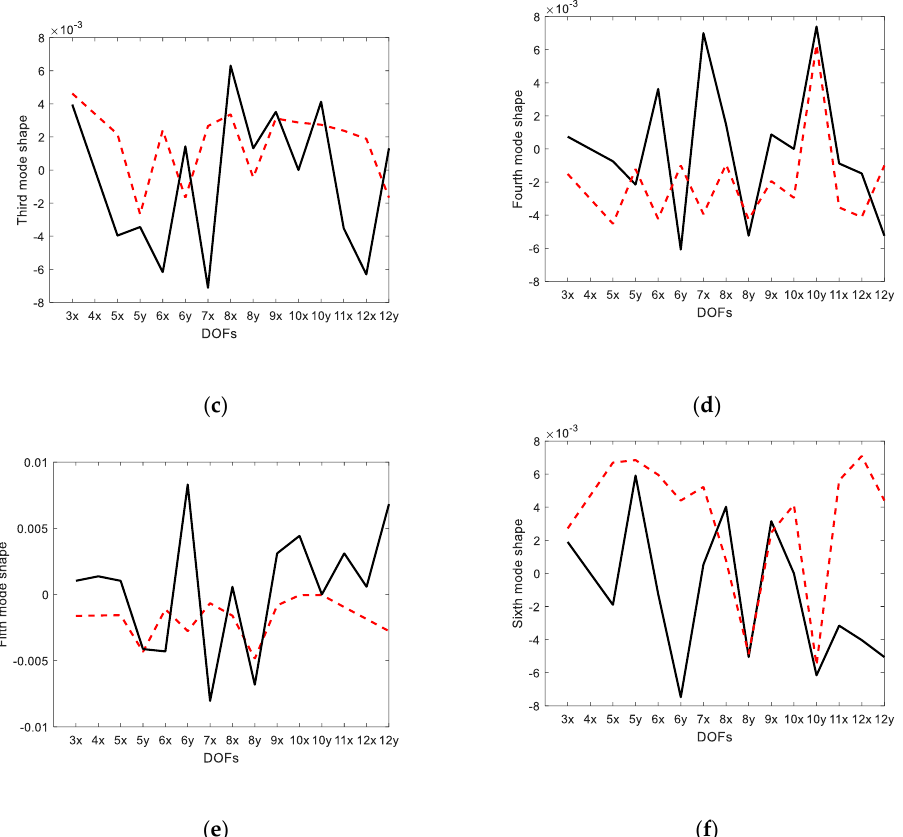
Figure 6. Comparison of estimated and actual mode shapes (G-EI approach) at slave DOFs: ( a ) first mode; ( b ) second mode; ( c ) third mode; ( d ) fourth mode; ( e ) fifth mode; ( f ) sixth mode. The solid line indicates the actual mode shape and the dotted line is the estimated mode shape.